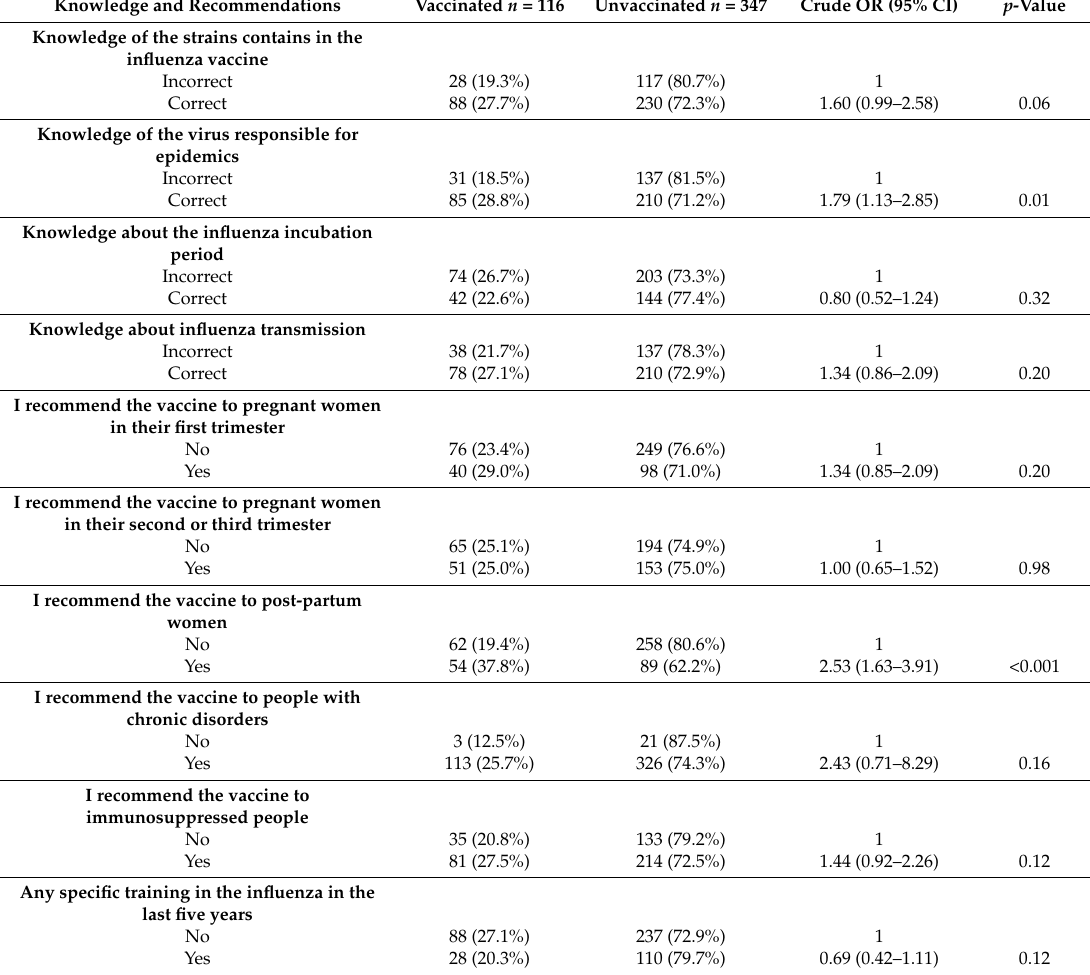
Table 2. Distribution of influenza vaccinated and unvaccinated community pharmacists in the 2013–2014 season according to knowledge of and recommendations about influenza and influenza